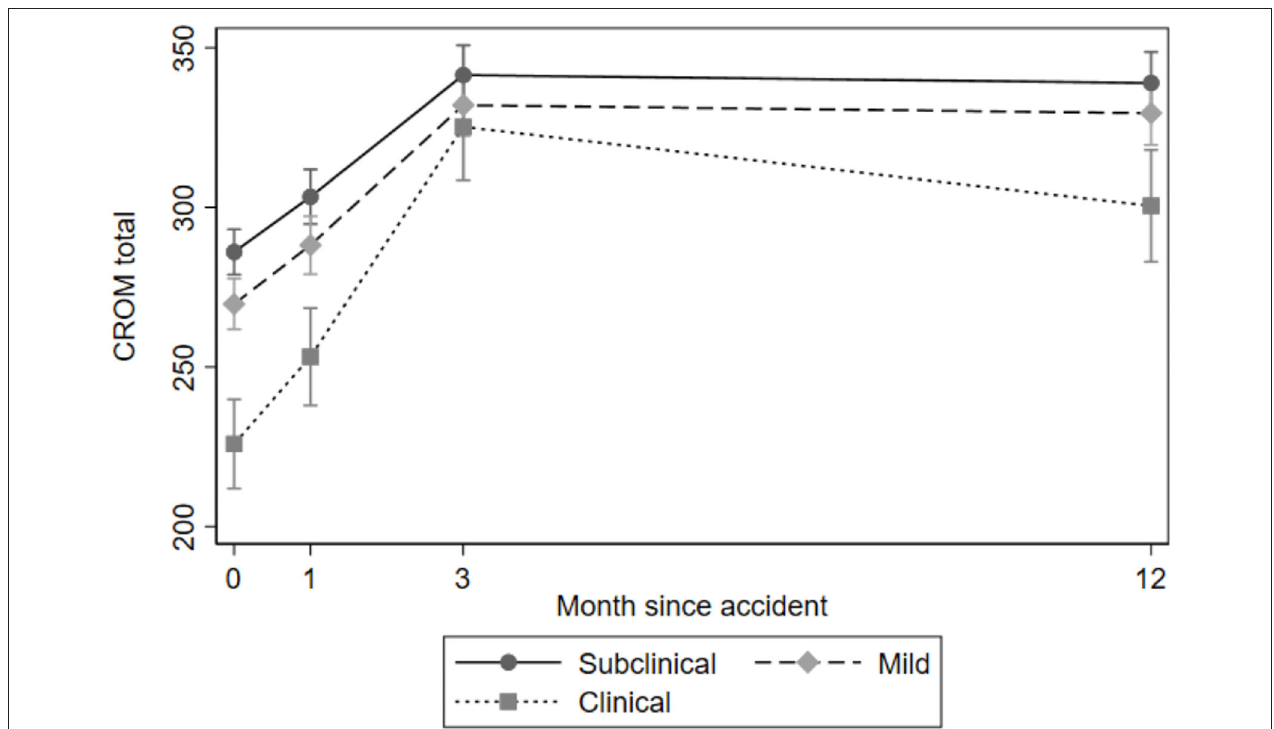
FIGURE 2 | Cervical range of motion by PTSS groups over